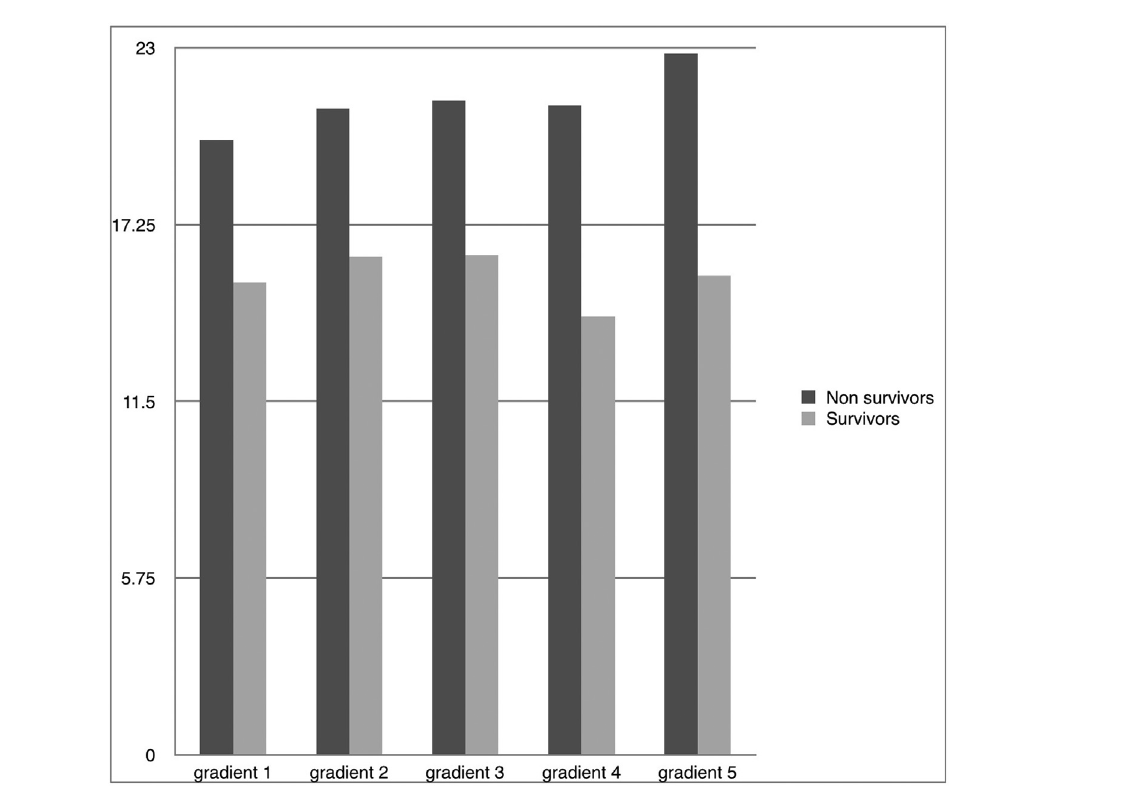
Gradient difference in survivors and nonsurvivors.